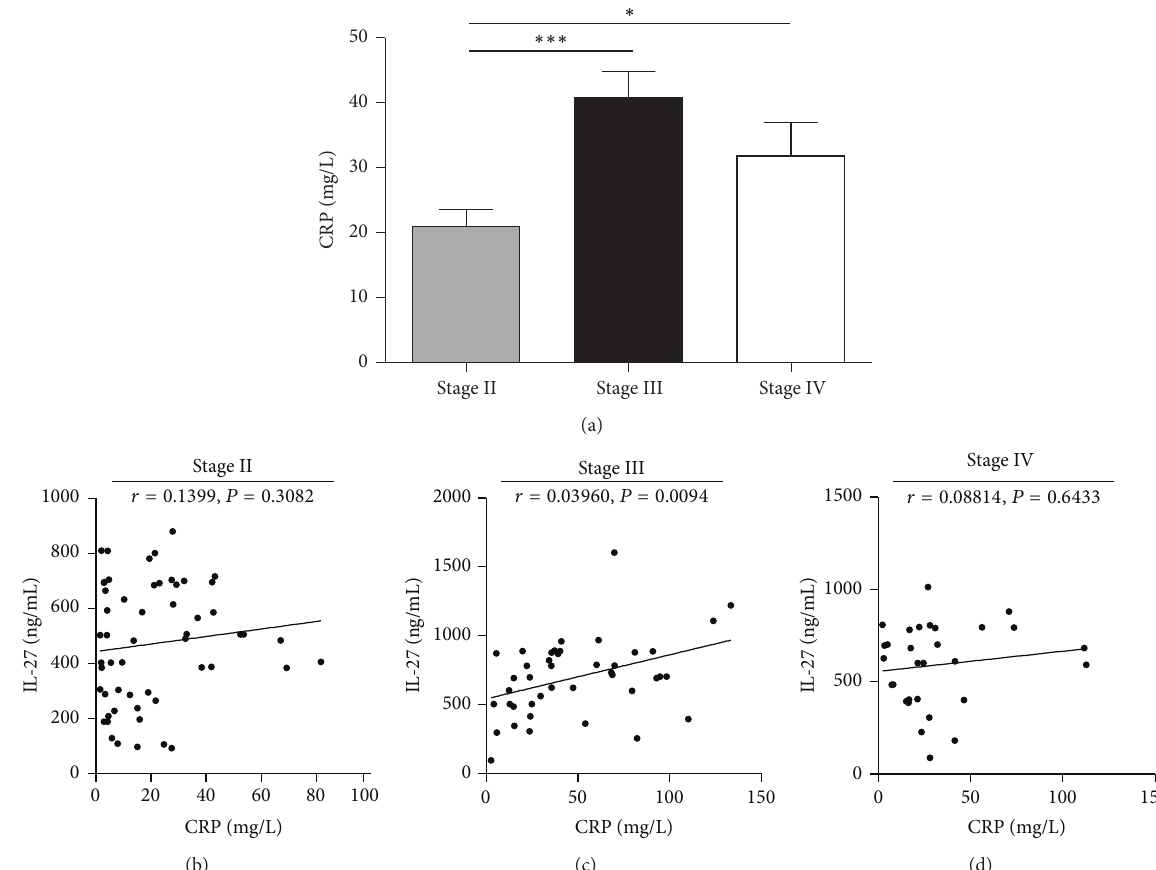
Figure 2: Correlation of serum IL-27 levels with CRP levels. (a) CRP levels in stage II, III, and IV EV71-infected patients. (b) Correlations of serum IL-27 levels with CRP levels in stage II EV71-infected patients. (c) Correlations of serum IL-27 levels with CRP levels in stage III EV71-infected patients. (d) Correlations of serum IL-27 levels with CRP levels in stage IV EV71-infected patients. ∗ 𝑃 < 0.05 ; ∗∗∗ 𝑃 < 0.001